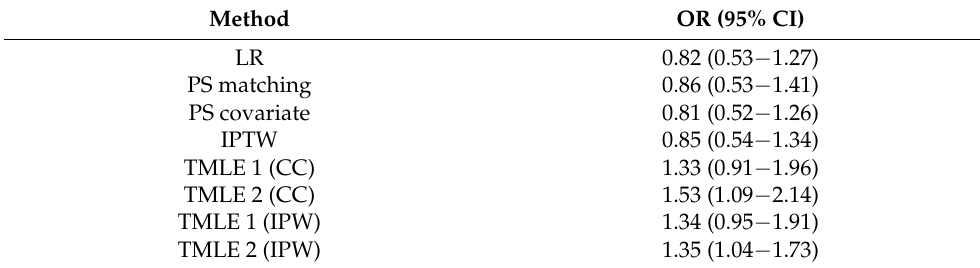
Table 1. The results of the DARWIN T2D study.